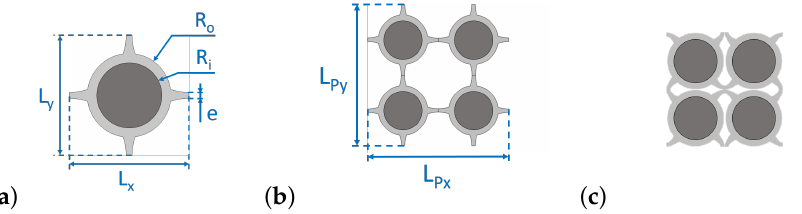
Figure 4. Resonant design S R with its characteristic dimensions for R i = 3 mm: ( a ) unit cell, ( b ) periodic pattern, and ( c ) pattern at ≈ 30% compression